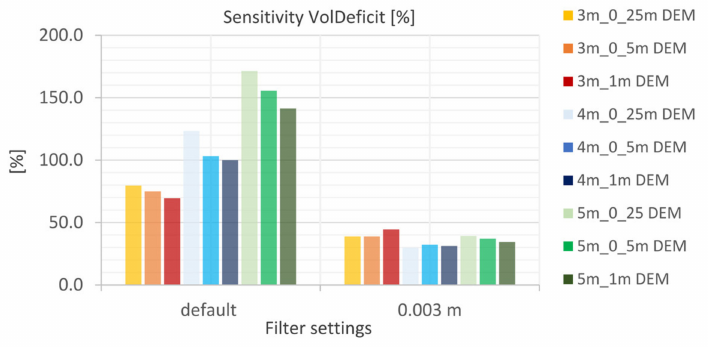
Figure 33. Comparison of the model sensitivity (S-VD) for the filter settings and the evaluated mesh and DEM